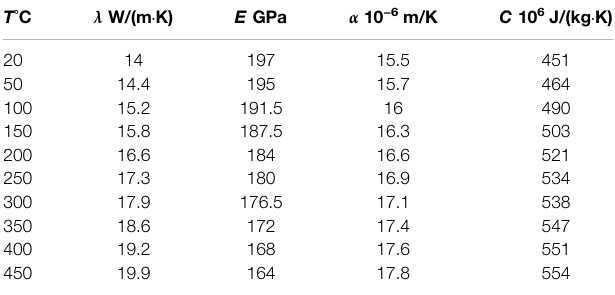
TABLE 5 | Material properties of cladding.